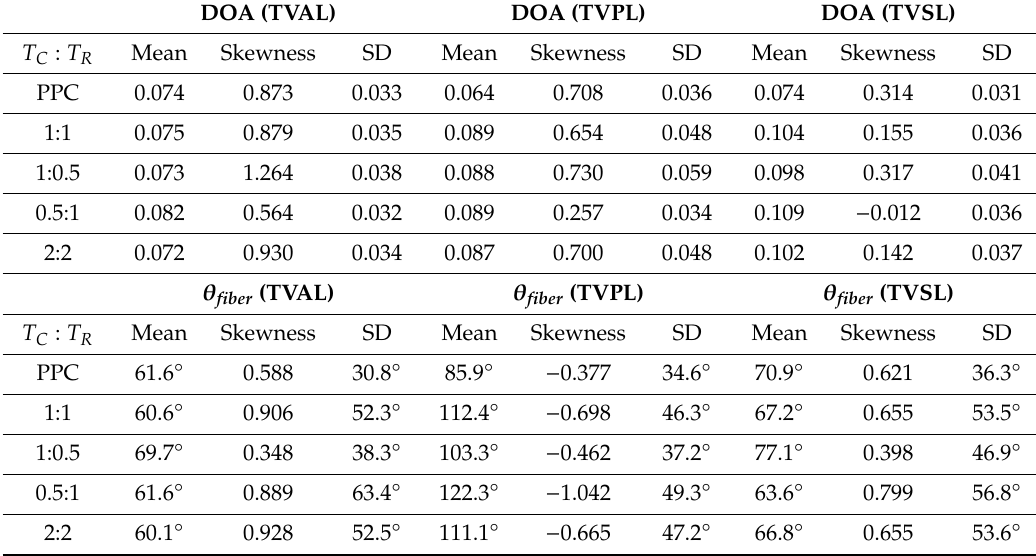
Table 5. Mean, skewness, and standard deviation (SD) for the predicted θ fiber and the DOA of the entire tissue’s ROI (see right column in Figure 3a–c) for the TVAL, TVPL, and TVSL specimens from heart #1, considering various biaxial tension loading